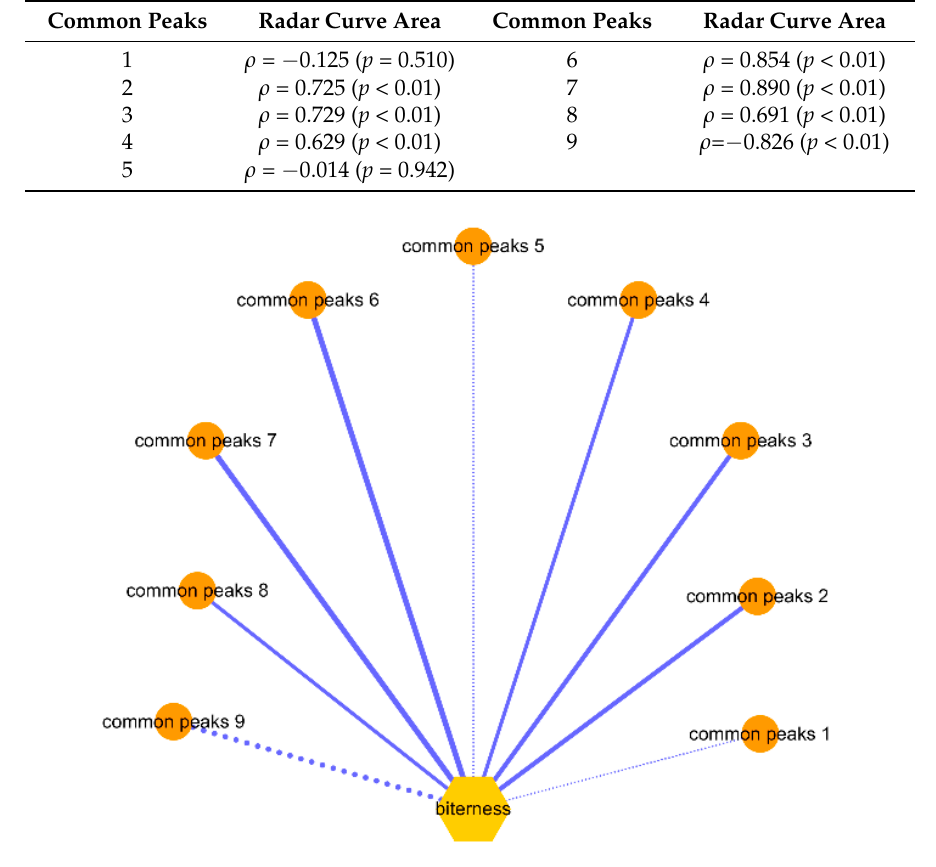
Figure 4. Correlation network between bitterness (radar curve area) and the common peaks in HPLC fingerprint. Visualization of data concentrated on the correlations between chemical constituents in relation to bitterness (radar curve area). The negative correlations are indicated with dots lines, and positive correlations are indicated with solid lines; thicker lines indicate a stronger correlation. The length of each line has no meaning.